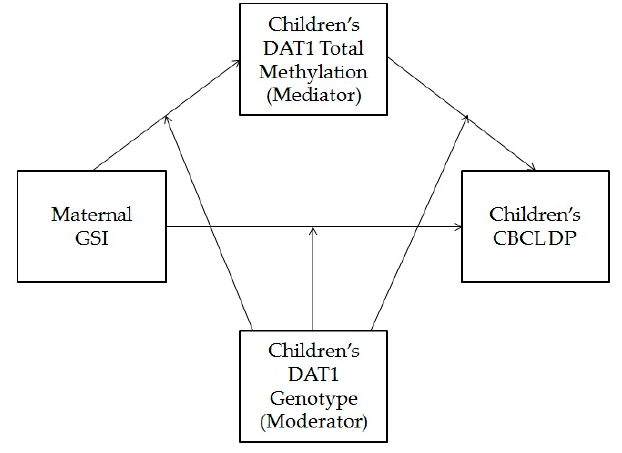
Figure 1. Diagram of moderated mediation model with children’s DAT1 total methylation as the